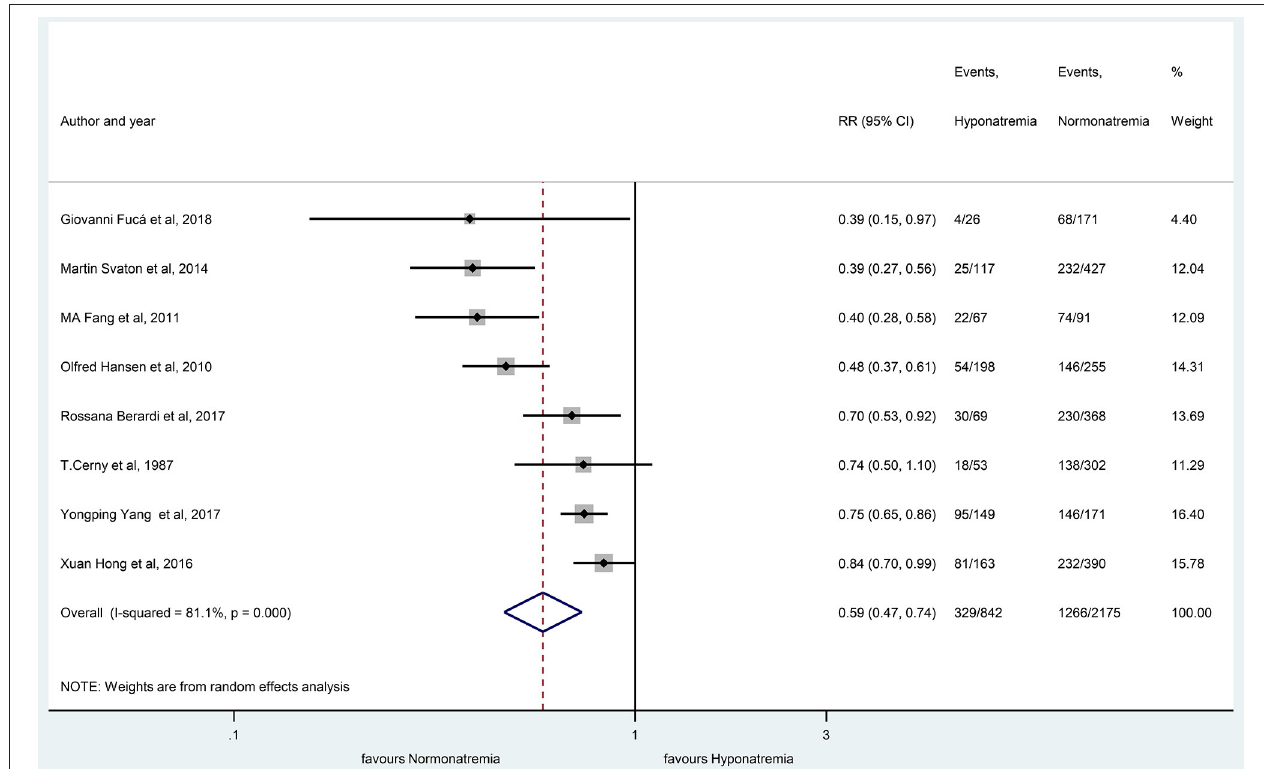
FIGURE 7 | The overall survival rates at 10 months, comparing patients with hyponatremic and normonatremic lung cancer. Black diamonds represent the individual effects of studies, and vertical lines show the corresponding 95% CI. The size of the gray squares reflects the individual weight of a particular study. The blue diamond shows the overall or summary effect. The outer edges of the diamonds represent the CIs. RR, risk